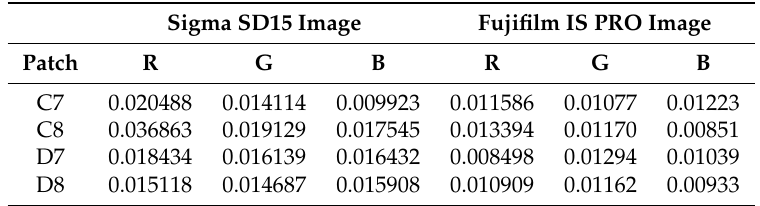
Figure 7. Noise comparative detail sRGB images after characterization: ( a – d ) Sigma SD15; ( e – h ) FujifilmIS PRO; ( a , e ) Original raw images; ( b , f ) Gaussian process; ( c , g ) Second-order polynomial model; ( d , h ) Linear model. Table 4. Noise variation coefficients of the original RGB digital numbers.